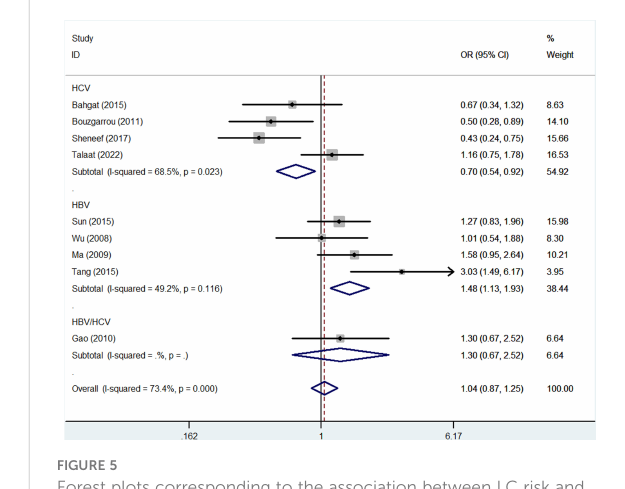
FIGURE 4 Forest plots corresponding to the association between LC risk and rs2430561 polymorphisms using an allelic contrast model in different ethnic subgroups.